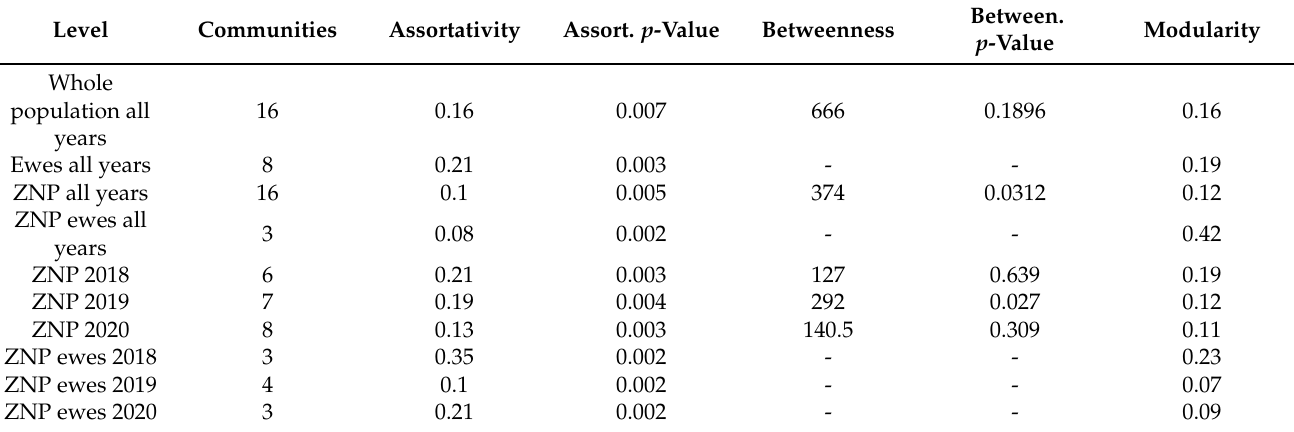
Table 2. Network metrics associated with various partitions of the Zion bighorn population